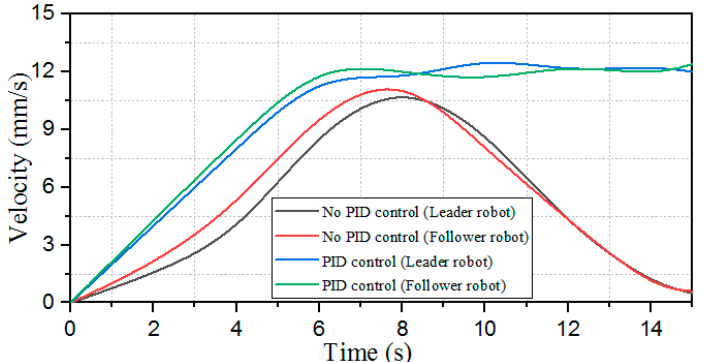
Figure 32. Experimental results of the velocity comparison.